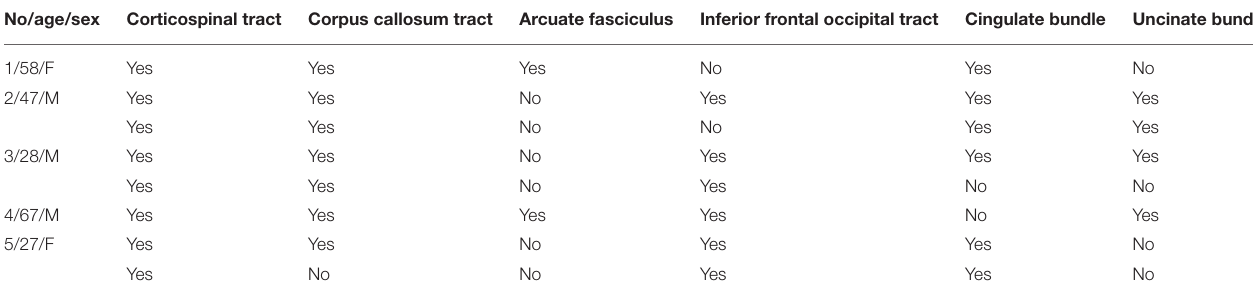
TABLE 2 | Diffusion tensor imaging results of five